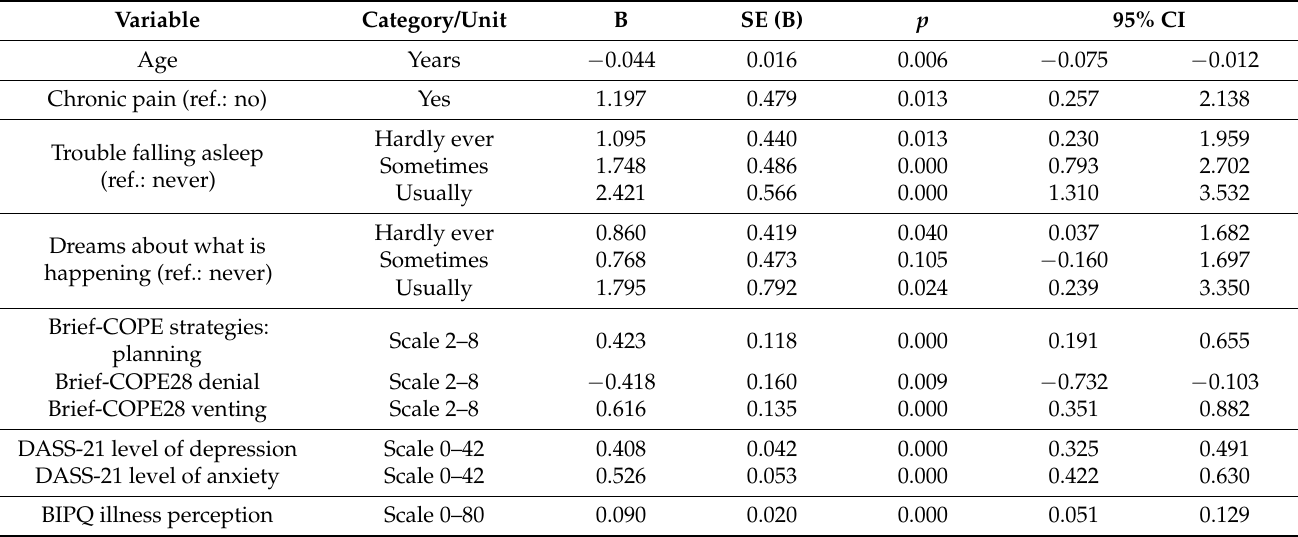
Table 5. Factors related to stress scores. Linear regression